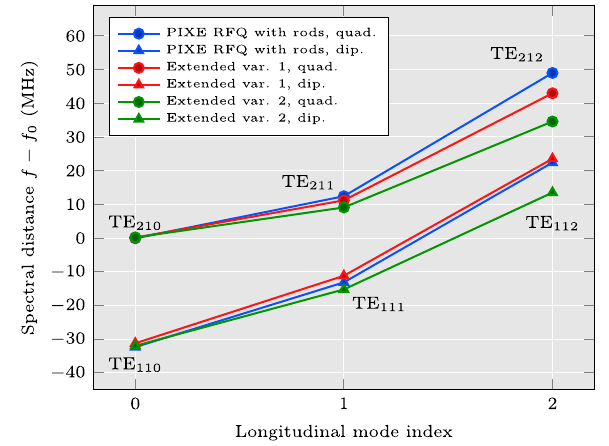
FIG. 20. Spectrum of PIXE RFQ with dipole stabilization rods compared to the spectra obtained by omitting the rods and extending the length of the cavity.